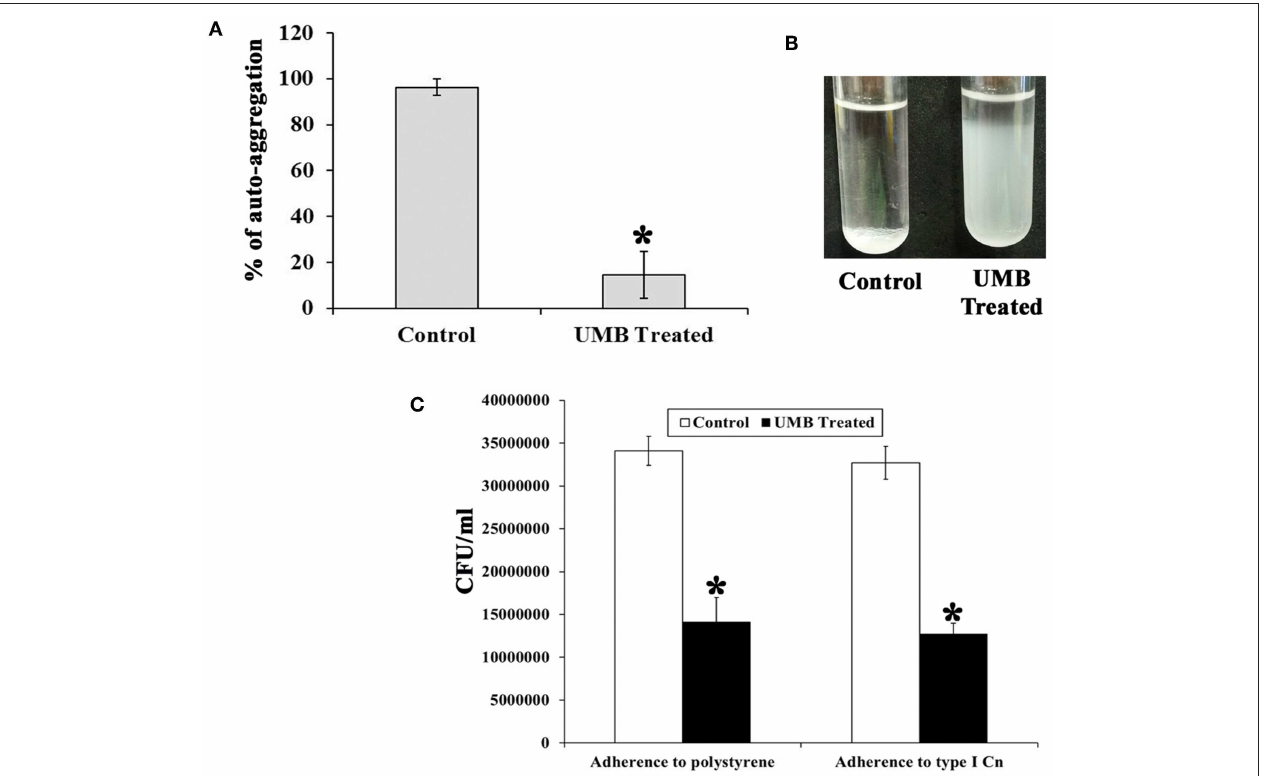
FIGURE 4 | Effect of UMB on rate of aggregation and adherence. (A) Bar graph depicts the rate of aggregation of MRSE cells in the absence and presence of UMB (at 500 µ g/ml). (B) Representative image of test tubes displaying abridged aggregation of UMB treated MRSE than that of the control cells. (C) Bar graph shows the rate of adherence of MRSE in the absence and presence of UMB (at 500 µ g/ml) indicating the reduced adherence of MRSE to polystyrene and type I Cn coated surfaces by UMB. Error bars indicate standard deviations. * Statistical significance between control and treated samples from three independent experiments ( p <